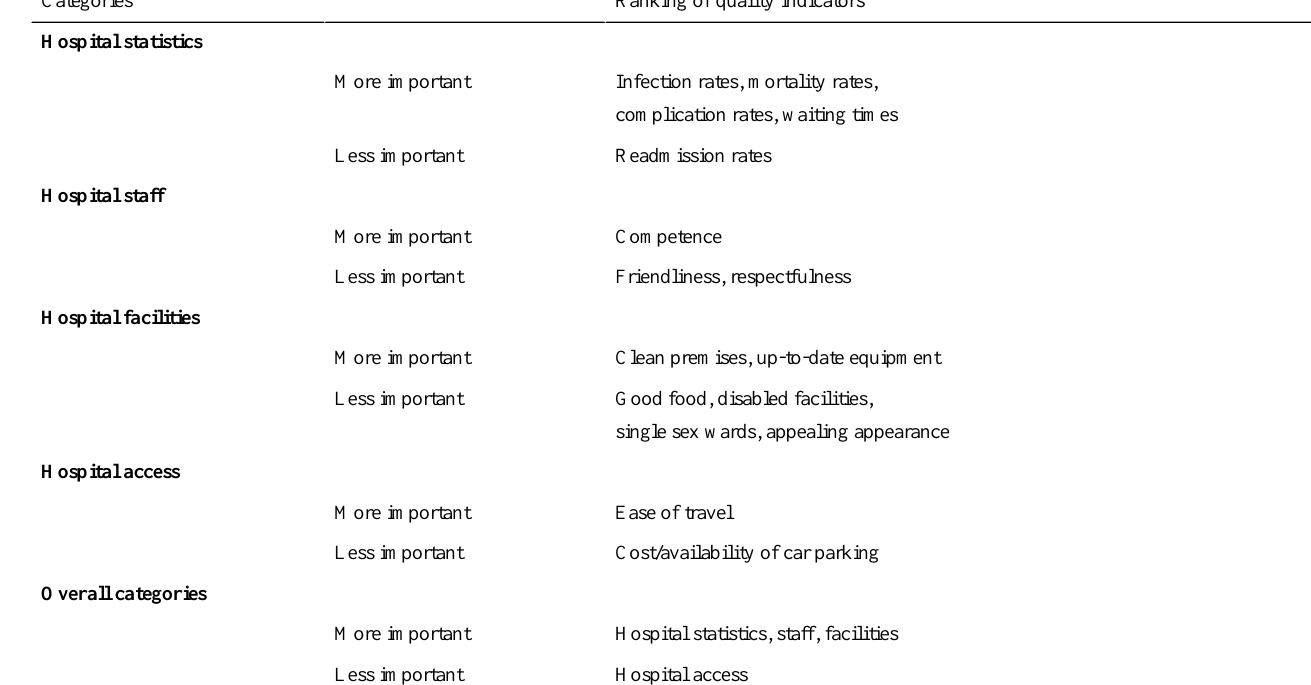
Table 3. Overall rankings of quality indicators within and between categories.